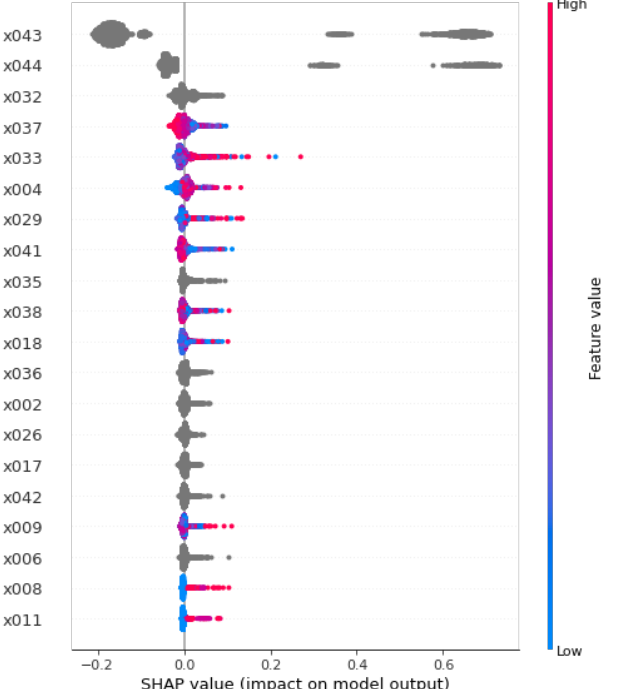
Figure 1. SHAP summary plot. The SHAP value of a predictor for a participant measures the difference between what machine learning predicts for the probability of GERD with and without the predictor. For example, in this hypothetical figure, the SHAP values of diabetes (x033) for GERD have the range of ( − 0.05, 0.30). Here, some participants have SHAP values as low as − 0.05, and other participants have SHAP values as high as 0.30. The inclusion of a predictor (diabetes) into machine learning will decrease or increase the probability of the dependent variable (GERD) by the range of − 0.05 and 0.30. In other words, there exists a positive association between diabetes and GERD in general.